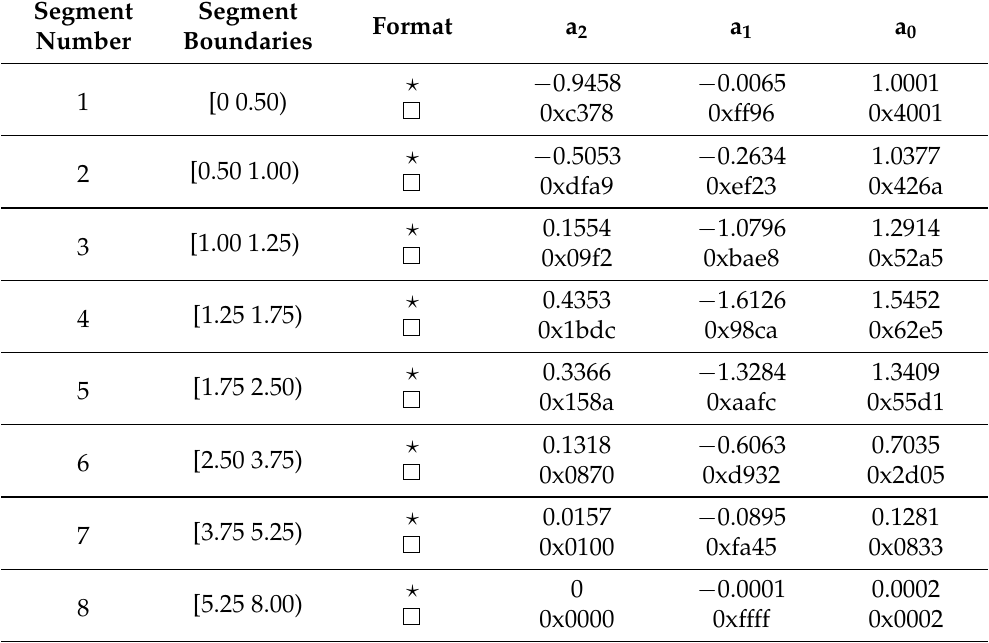
Table 5. Floating-point and fixed-point coefficients for implementing Gaussian AF in HNN.